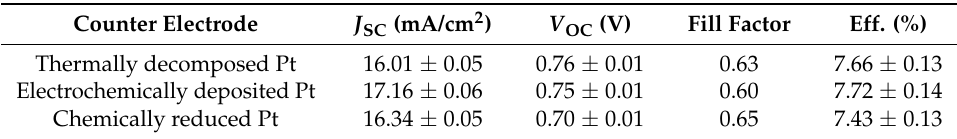
Figure 6. J - V curves of DSSCs based on various Pt CEs. Table 1. Photovoltaic characteristics of DSSCs based on various Pt counter electrodes.